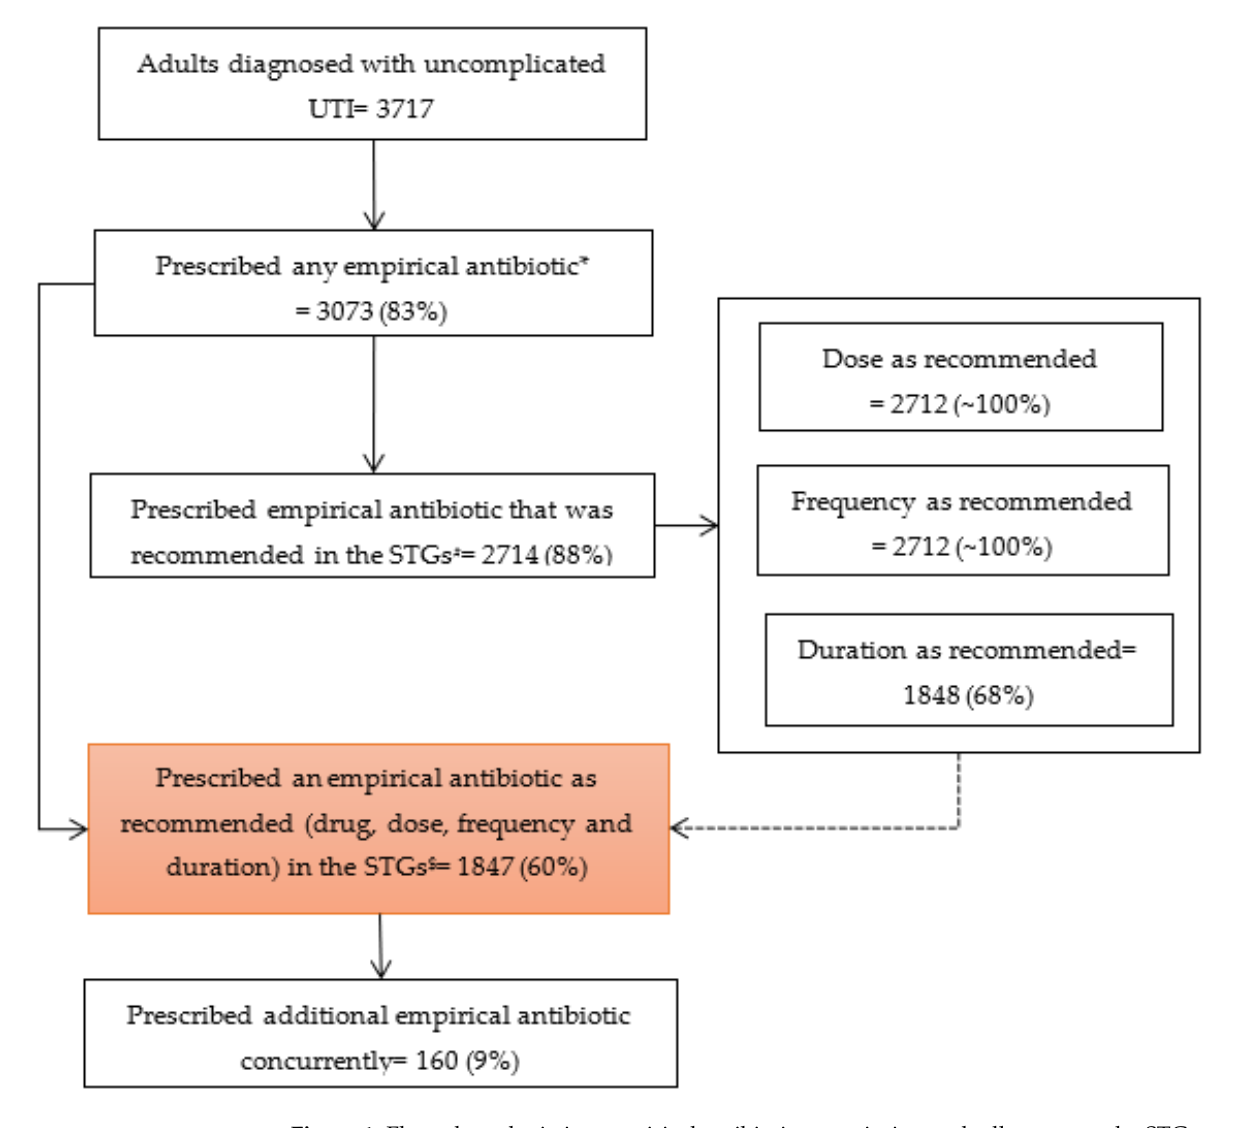
Figure 1. Flow-chart depicting empirical antibiotic prescription and adherence to the STGs among adults diagnosed with uncomplicated UTIs in the outpatient department of the Korle Bu Poly- clinic/Family Medicine Department of Ghana during October 2019 to October 2021. * Prescription of antibiotic of any class by the treating physician; # Prescription of either oral ciprofloxacin or cefuroxime as recommended in the STGs; $ Prescription of either oral ciprofloxacin or cefuroxime recommended at the dose, frequency, and duration as recommended in the STGs; UTI = Urinary Tract Infection; STGs = Standard Treatment Guidelines.